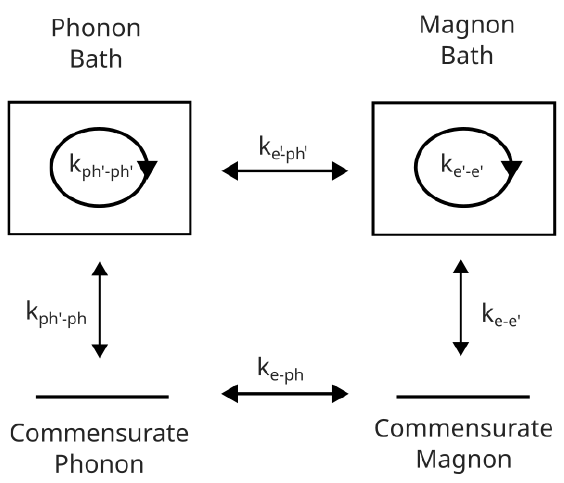
Figure 4. Schematic of the possible interactions between the magnon associated with the selected spin transition, its commensurate phonon, and the baths of available phonon and magnon